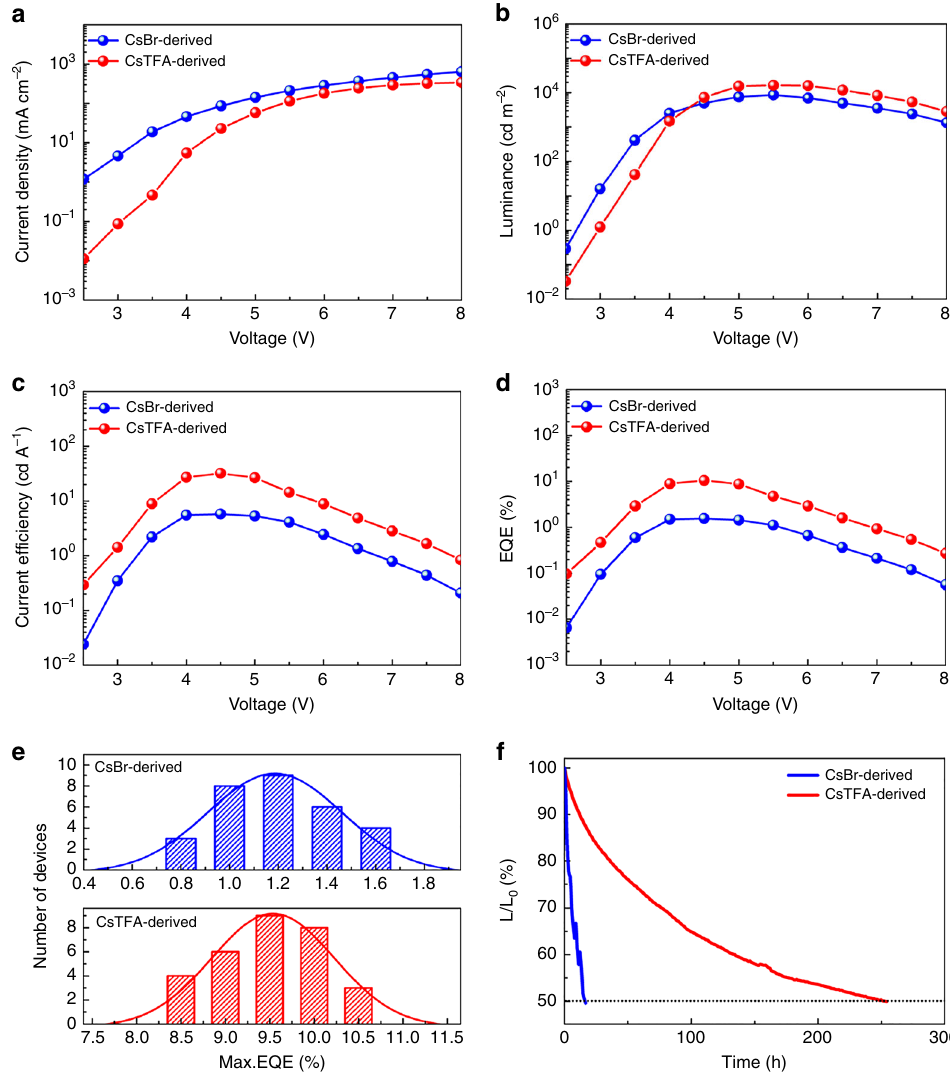
Fig. 7 Device performance of the CsB- and CsTFA-derived PeLEDs. a J – V , b L – V , c CE – V , d EQE – V curves, e performance reproducibility, and f operational lifetimes of the PeLEDs based on CsBr(1.7)- and CsTFA(1.7)-derived CsPbBr 3 perovskite fi electrical shunting paths. The turn-on voltages for the two types of devices were close, namely 2.8 V for the CsTFA-derived device and 2.5 V for the CsBr-derived one. However, the maximum luminance (16,436 cd m − 2 ) of the PeLED based on the CsTFA-derived perovskite fi lm was two times higher than that of the CsBr- derived one (8628 cd m − 2 ). The maximum CE (32.0 cd A − 1 ) and EQE (10.5%) of the PeLEDs based on the CsTFA-derived fi lms were much higher than those of the CsBr-derived ones (maximum CE 5.78 cd A − 1 , and maximum EQE 1.6%). Figure 7e provides the histogram of the maximum EQE values for 30 devices based on CsBr- and CsTFA-derived fi lms, operated under respective optimal conditions. The average maximum EQEs for the devices based on CsBr- and CsTFA-derived fi lms were 1.2% and 9.4%, respectively. We note, that compared to the CsBr-derived devices, the CsTFA- derived ones show signi fi cantly lower standard deviation (5.4% versus 19.9%), demonstrating the good performance reproducibility of these PeLEDs. Besides, TFA-derived mixed-cation FA 0.11